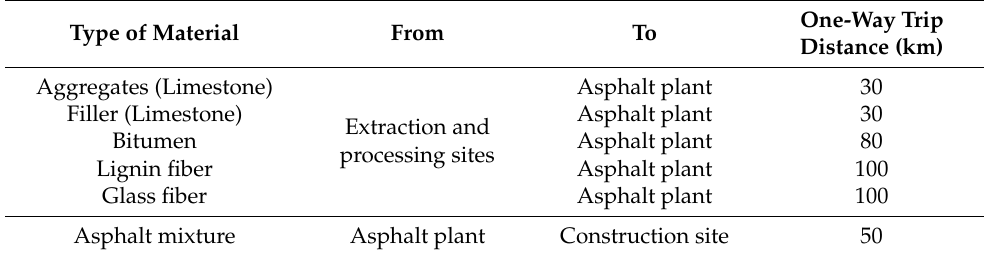
Table 3. Transportation distances considered in this